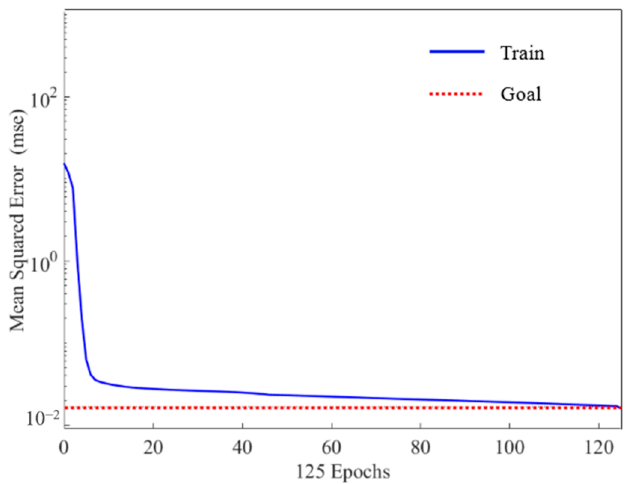
Figure 9. Training convergence curve for the optimal ANN model.